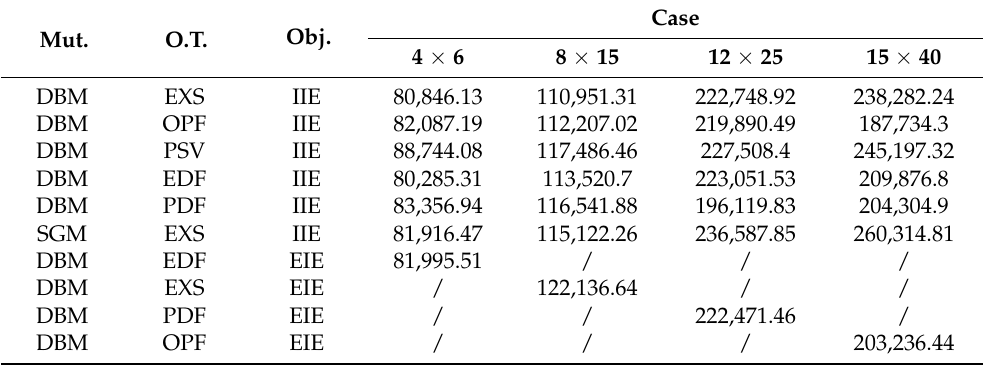
Table 6. Minimal PC obtained by replicated configuration experiments.